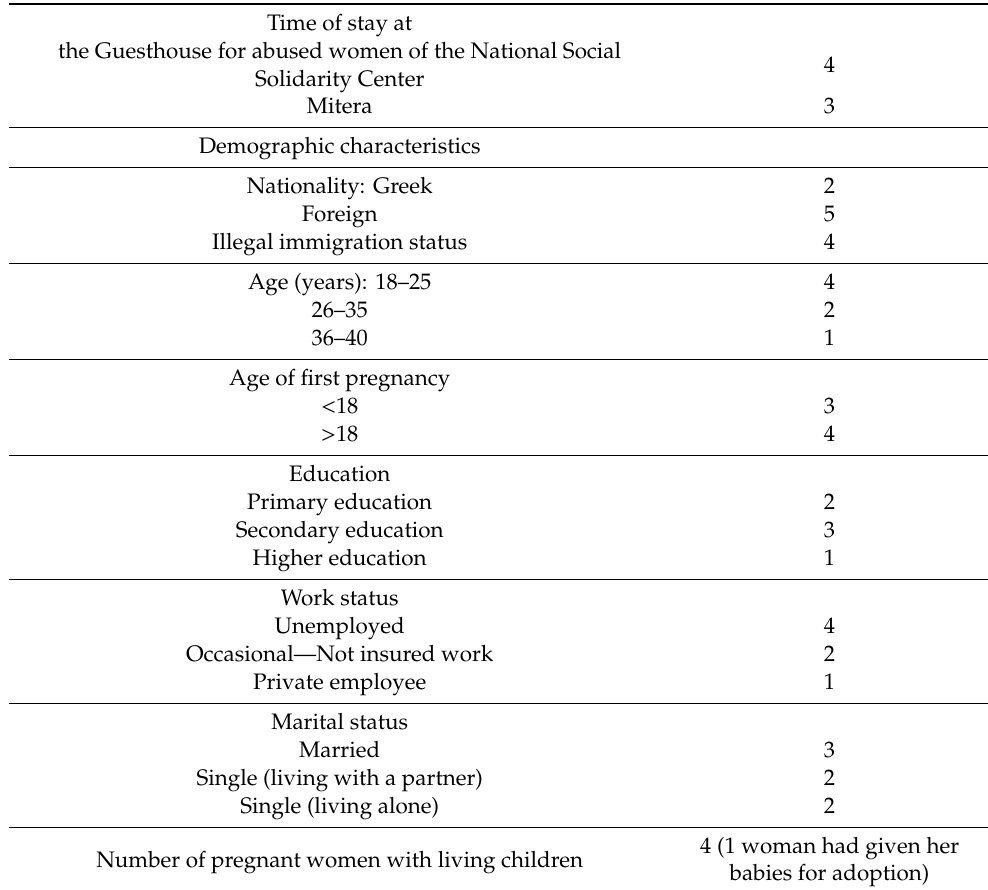
Table 1. Profile of abused pregnant woman.